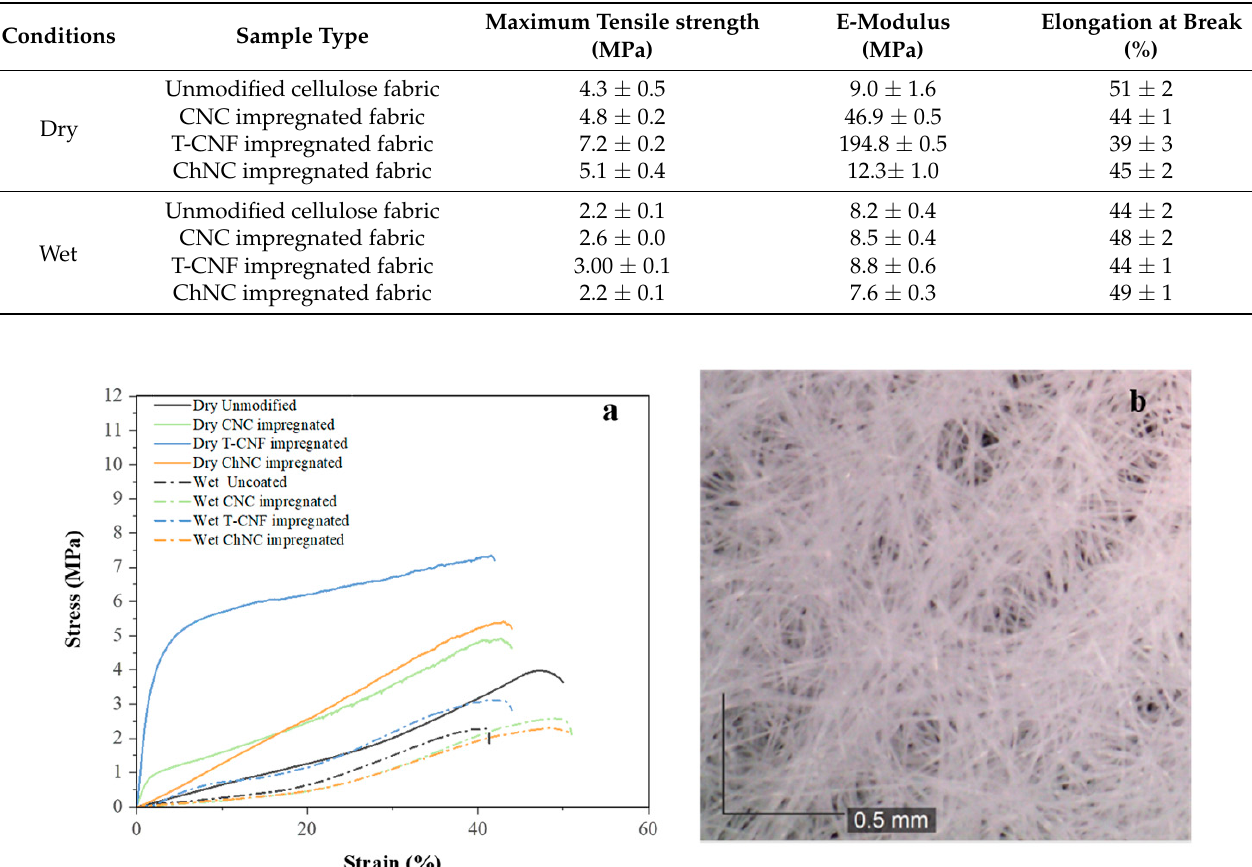
Figure 3. ( a ) Stress–strain curves in dry and wet conditions of unmodified, CNC impregnated, T-CNF impregnated and ChNC impregnated fabrics, and ( b ) random orientation of nonwoven fibers.